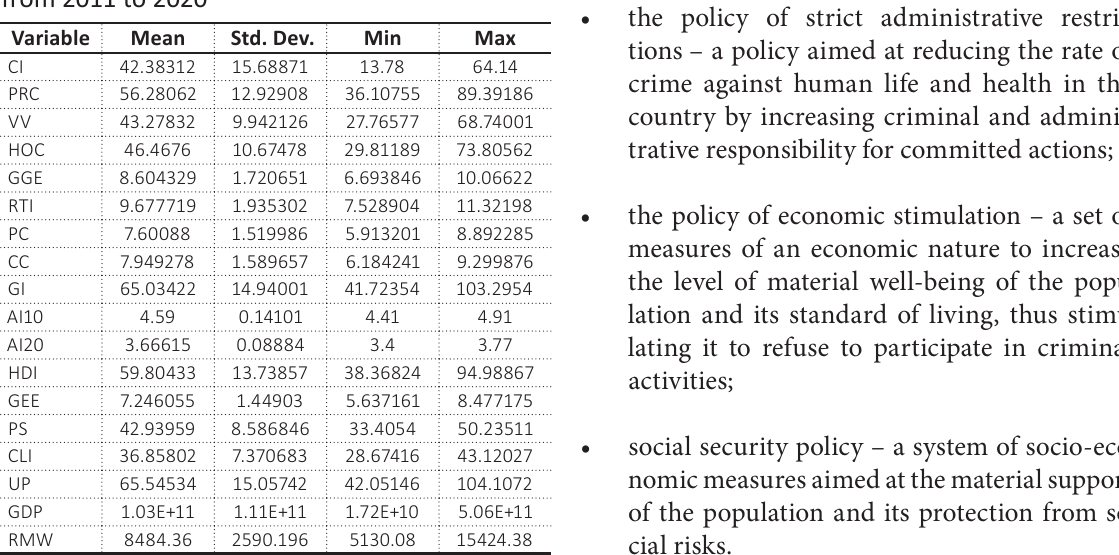
Table 7. Descriptive statistics for the third cluster